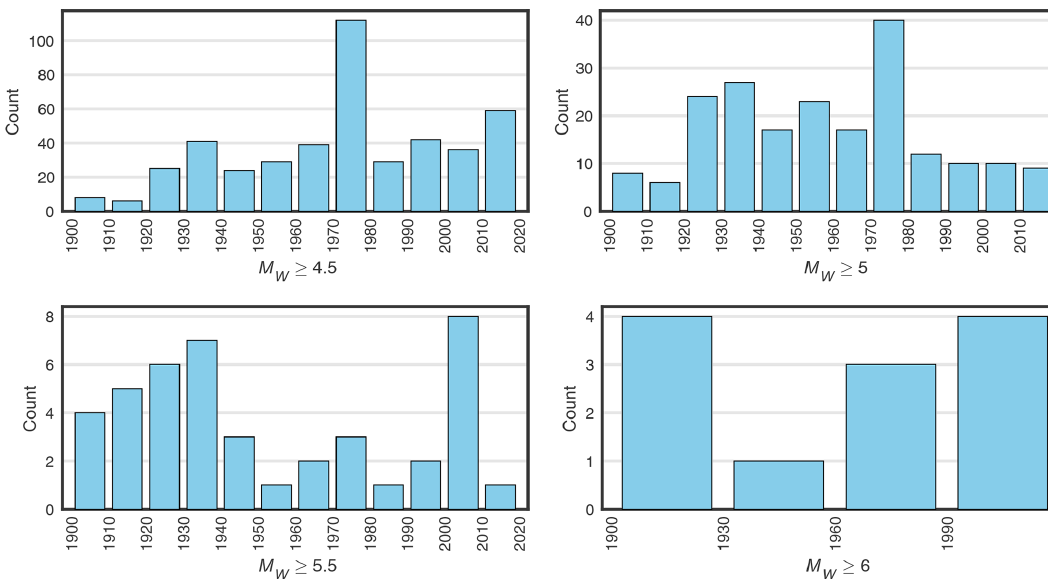
Figure 6. Count of earthquakes in the NMAR region exceeding different M w thresholds according to period.